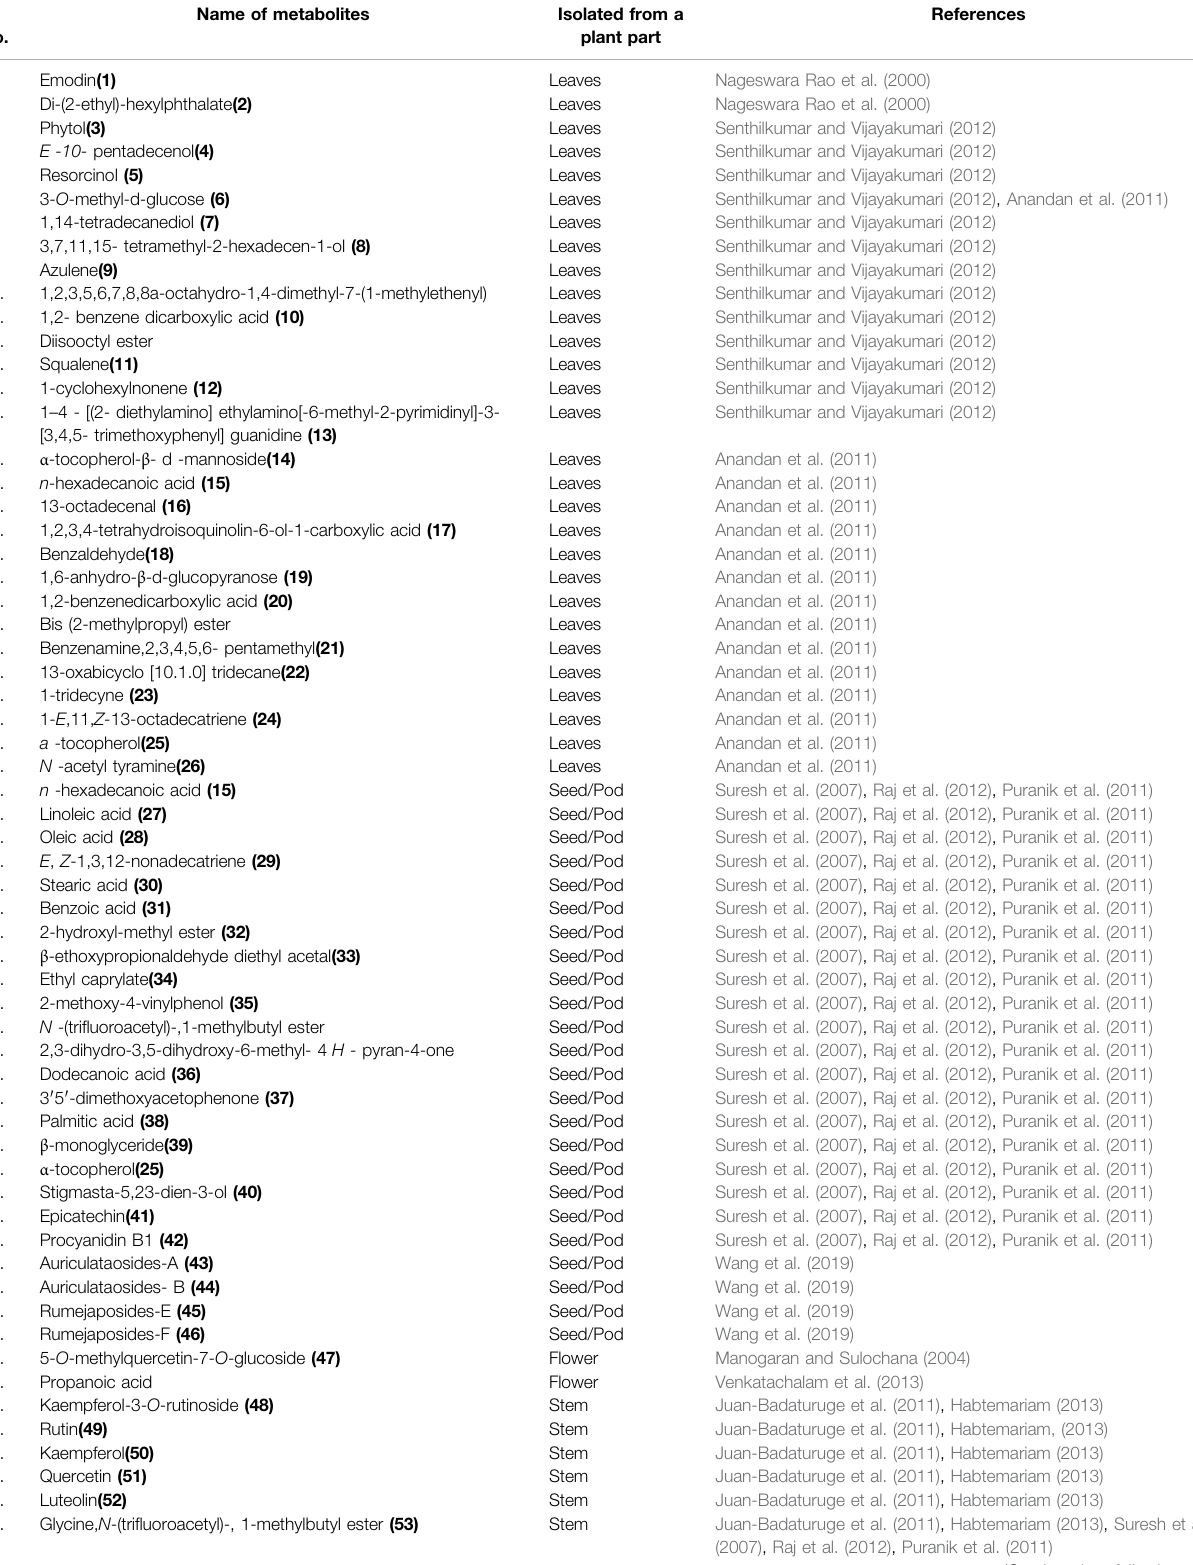
TABLE 1 | Metabolites of Senna auriculata (L.)